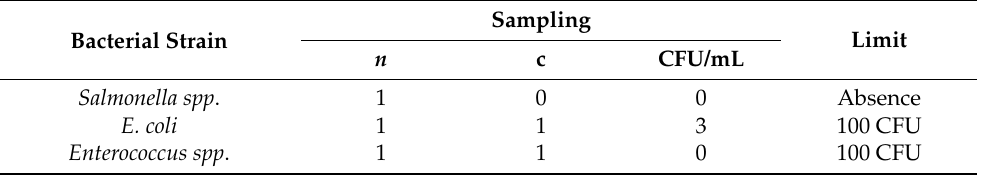
Table 1. Microbiological assessment of the rinsed shell powders, according to the requirements of